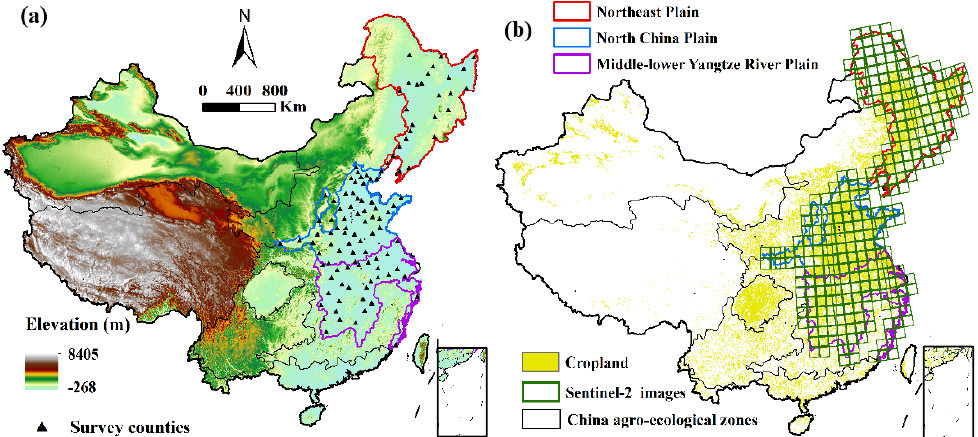
Figure 1. The spatial distribution of the elevation and survey sites ( a ), and the cropland and Sentinel-2 images ( b ) in the main grain-producing area of China, including the Northeast Plain (red frame), North China Plain (blue frame), and middle-lower Yangtze River plain (purple frame). The rectangle in the right-bottom corner represents China’s Nansha Islands and the nine-dash line.